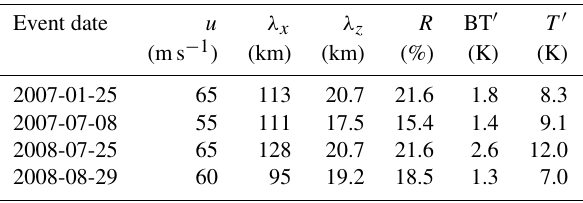
Table 2. Estimation of gravity wave amplitudes for the orographic events shown in Fig.